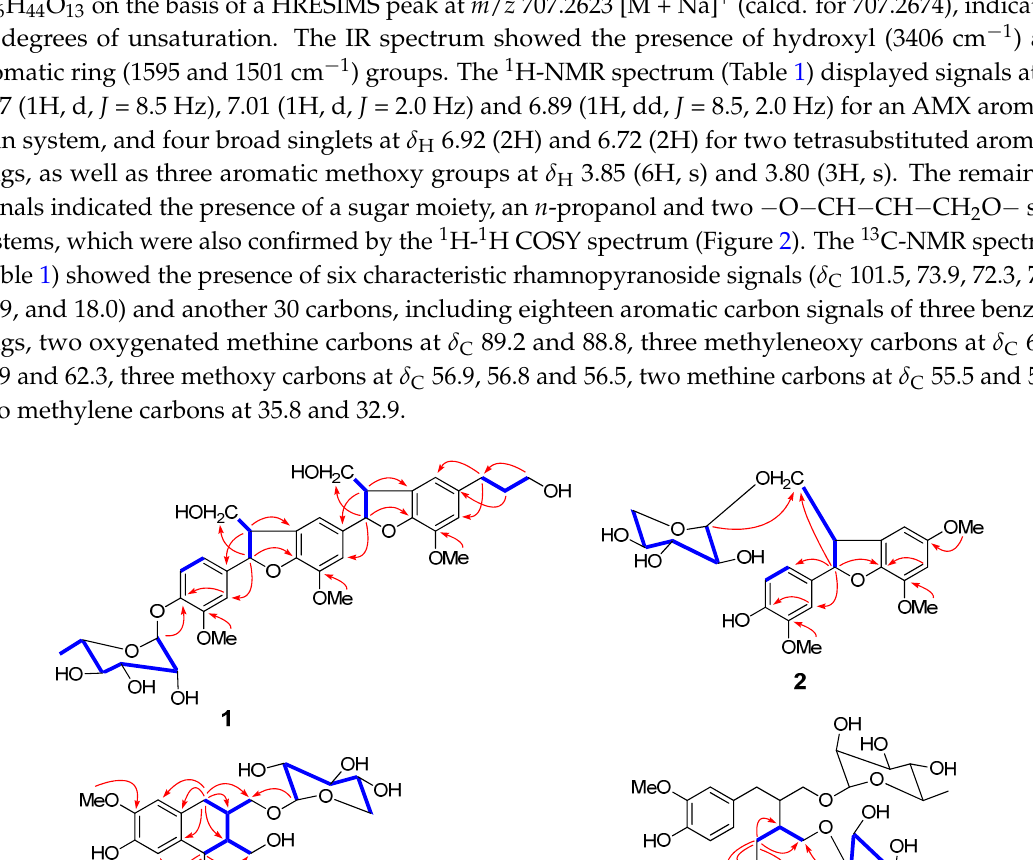
Figure 2. Key 1 H- 1 H COSY and HMBC correlations of compounds 1 − 4 .